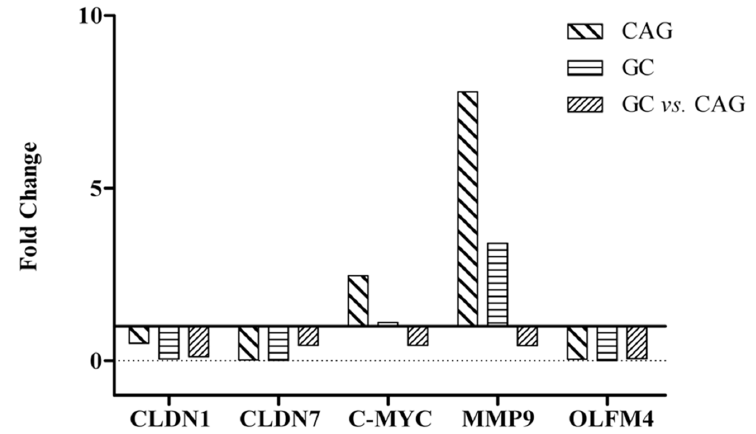
Figure 4. Quantitative PCR verification for claudin-7 ( CLDN7 ), olfactomedin-4 ( OLFM4 ), claudin-1 ( CLDN1 ), MYC ( C-MYC ), and matrix metalloproteinase-9 ( MMP9 ) in samples from patients with follicular gastritis, chronic atrophic gastritis, and gastric cancer. Log2 expression ratios are plotted; y -axis details fold change relative to log actin beta ( ACTB ).